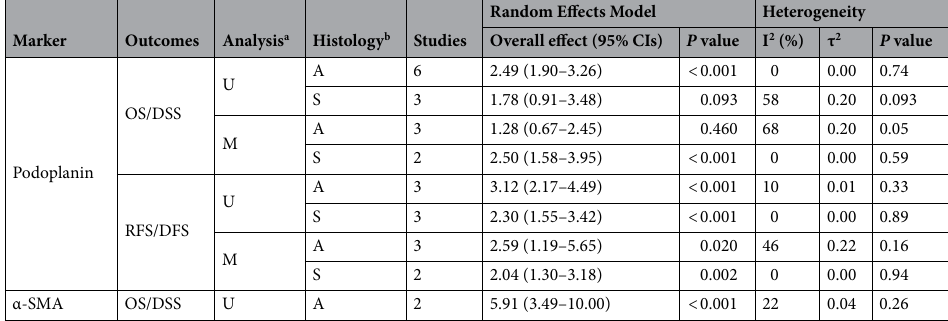
Table 2. Subgroup analysis: summary of results from the random effects models for individual markers based on histology sub-type. a U univariate, M multivariate. b A adenocarcinoma, S squamous.